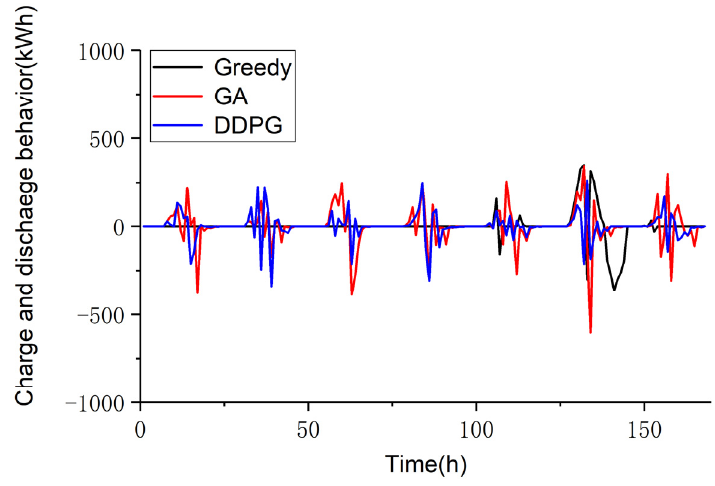
Figure 11. Energy of charge and discharge of energy management experiments.